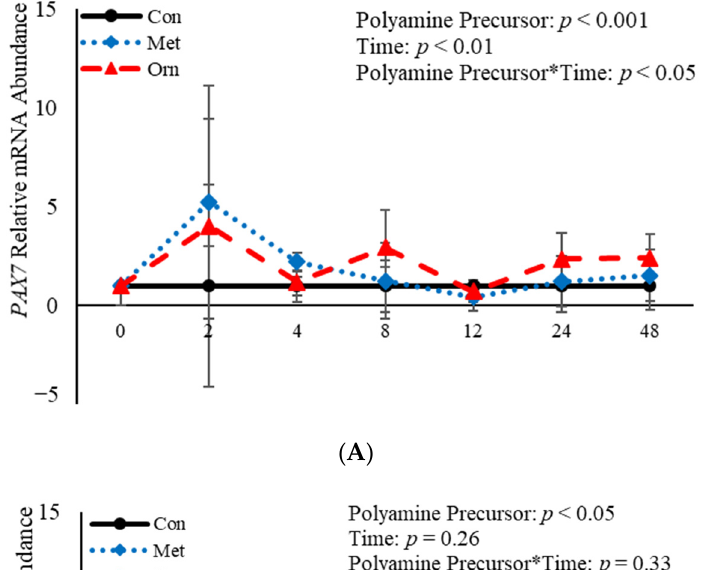
9 of 20 Figure 3. Relative mRNA abundance of S-adenosylmethionine decarboxylase ( AMD1; ( A ) and orni- thine decarboxylase (ODC; ( B ) from primary bovine satellite cells cultures following treatment with 10 nM trenbolone acetate (TBA), 10 nM estradiol (E2), or 10 nM E2 and 10 nM TBA (E2/TBA). Cul- tures were grown to 80% confluency and treated with DMEM/3% horse serum and 10 nM TBA, 10 nM E2, or 10 nM E2/TBA. Abundance was measured 0, 2, 4, 8, 12, 24 and 48 h after treatment, as described in the Materials and Methods. The main effects of steroidal hormone, time and steroidal hormone *time in mRNA abundance were analyzed as repeated-measures. Data represent relative mRNA abundance normalized against 18S abundance and are presented as LS mean ± SEM from six separate replicates utilizing BSCs isolated BSCs isolated from at least three different animals. Differences ( p < 0.05) between steroidal hormones found in anabolic implants and the control cul- tures are indicated by a * at that particular time point. 3.3. The Effects of Polyamine Precursors on Abundance of mRNA Related to Satellite Cell Differentiation No effect ( p > 0.05) of the interaction between polyamine precursor*time was ob- served in mRNA abundance of MYF5 or MYOD , however there was a polyamine precur- sor*treatment effect ( p = 0.04) observed for PAX7 mRNA (Figure 4) . Relative mRNA abun- dance of PAX7 was affected ( p < 0.001) by treatment when a polyamine precursor when analyzed as a repeated measure. However, neither polyamine precursor affected ( p > 0.05) abundance of PAX7 compared to the control cultures at any of the analyzed time points (Figure 4A). Additionally, mRNA of MYF5 was affected ( p = 0.05) by treatment with pol- yamine precursors (Figure 4B). Compared to control cultures, MET increased ( p = 0.05) abundance of MYF5 4 h post-induction to differentiate (Figure 4B). No effect ( p > 0.05) of treatment with polyamine precursor was observed in abundance of MYOD . However, MET increased ( p = 0.008) MYOD abundance 24 h post-induction to differentiate com- pared to control cultures (Figure 4C). Additionally, ORN increased mRNA abundance of MYOD 8 h ( p = 0.05) and 24 h ( p = 0.007) post-induction to differentiate compared to con-